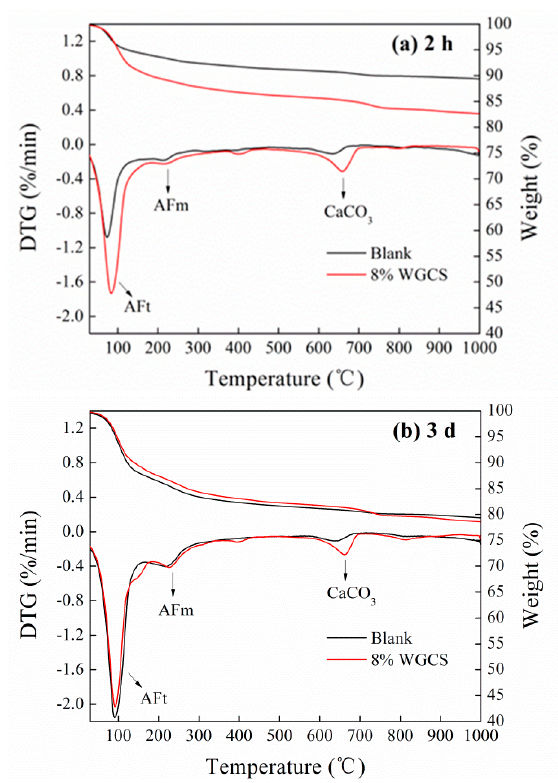
Figure 7. Thermogravimetry (TG)–Differential thermal gravity (DTG) patterns of CS–CSA paste. ( a ) 2 h; ( b ) 3 d.